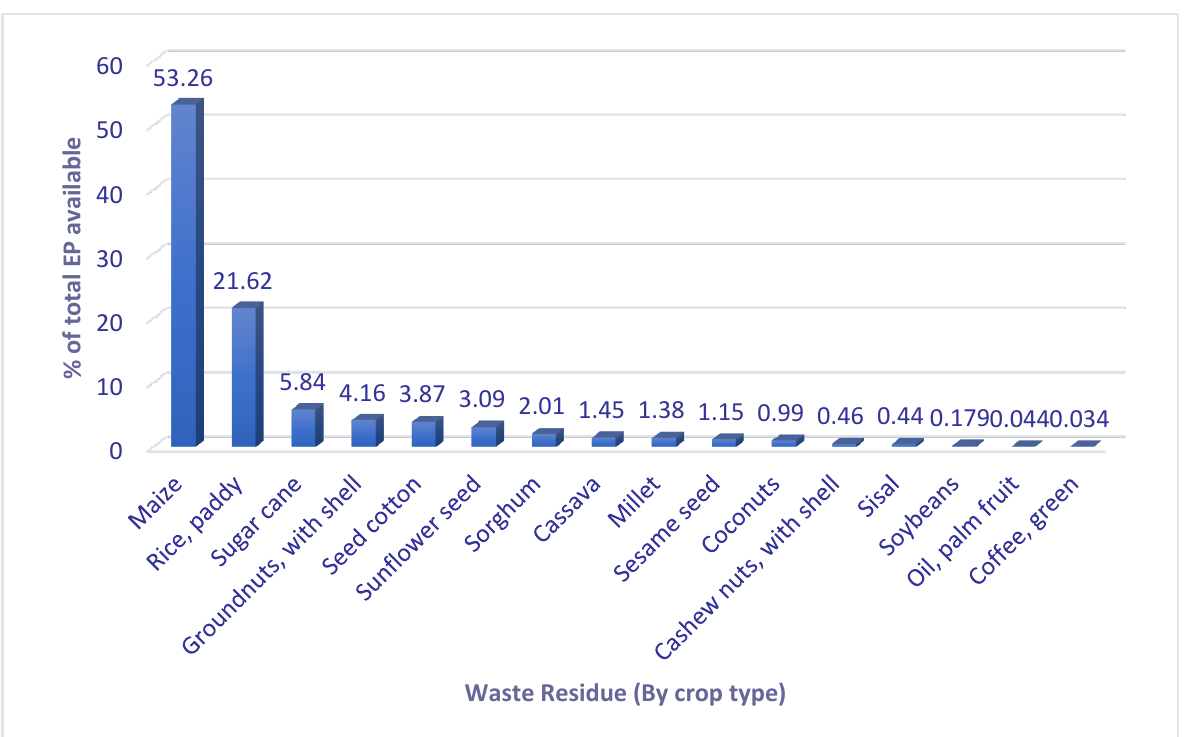
Figure 2. The % of the total energy potential available by crop type. Table 5. The energy potential arising from waste agricultural residues.